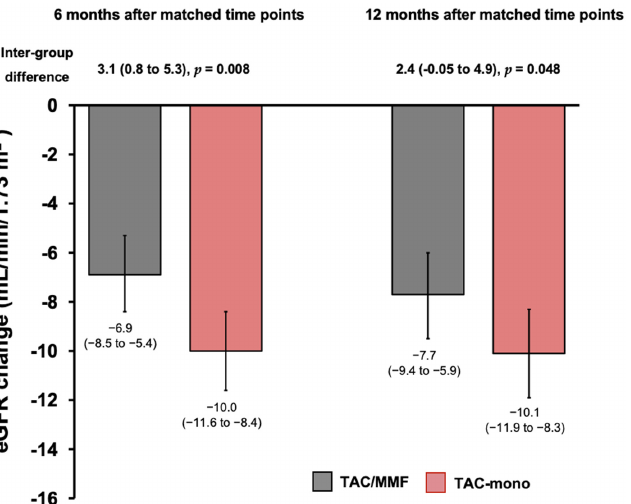
Figure 3. Comparisons between TAC/MMF and TAC-mono groups of the mean estimated glomerular filtration rate (eGFR) declines over six and 12 months after matched time points. The end of the box means mean eGFR decline and the error bar means a 95% confidence interval. LT, liver transplantation; MMF, mycophenolate mofetil; TAC, tacrolimus.